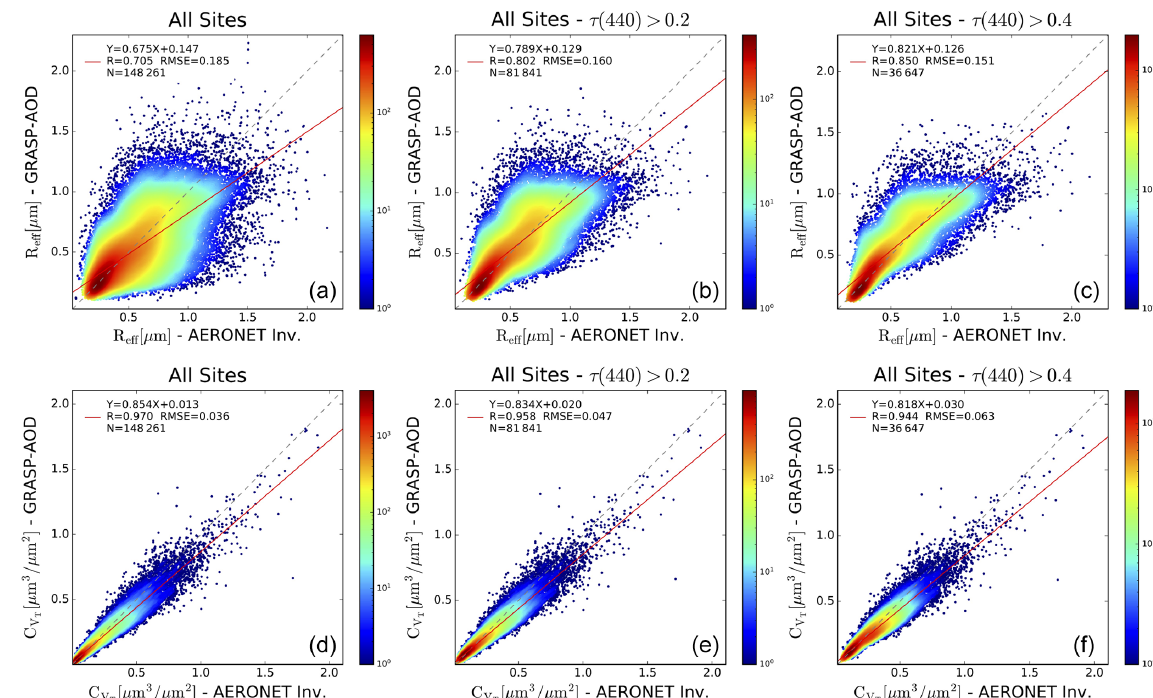
Figure 10. Comparisons between the effective radius and the total volume concentration obtained by the GRASP-AOD and AERONET aerosol retrieval algorithm for all sites considered in the analysis (Table 1) for the period 1997–2016. Comparisons for the effective radius ( R eff [µm]) are represented in (a) – (c) , while comparisons for the coarse-mode volume concentration ( C V Different thresholds for τ( 440 ) have been applied in the comparisons from (a) to (c) and from (d) to (f) : all the retrievals ( τ( 440 ) > 0 . 02), retrievals with τ( 440 ) > 0 . 2 and retrievals with τ( 440 ) > 0 . 4. Color bars represent data density in a 0 . 02 × 0 . 02µm grid for R eff and